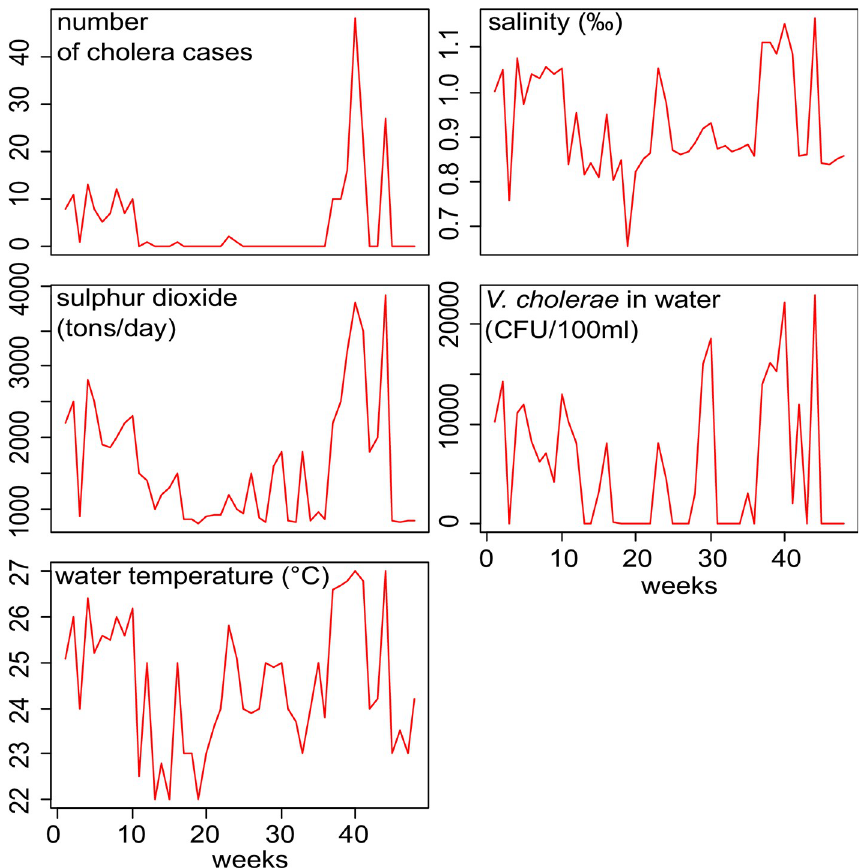
Fig 3. Time series plot of cholera cases, water vibrio occurrence and environmental variables for the period of 2016 to 2017, Katana health zone, DR Congo (n = 48).